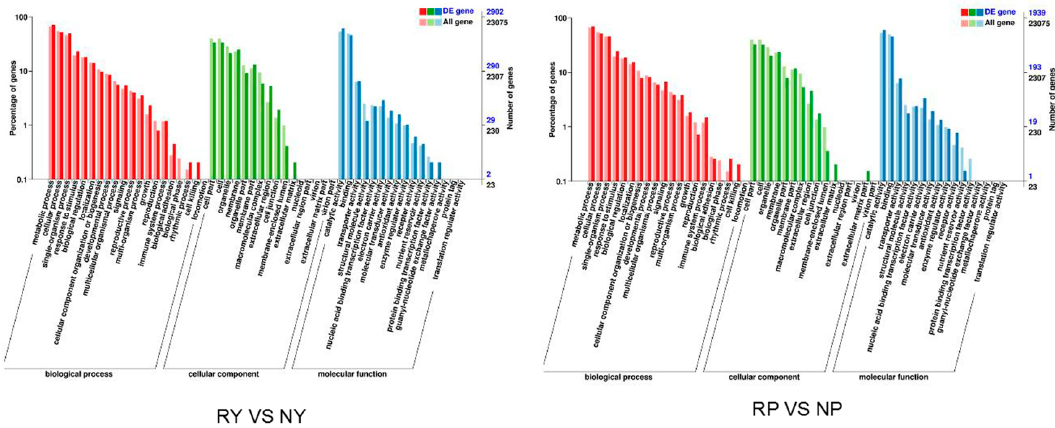
Figure 2. GO classification of unigenes in Juglans regia L. leaf and peel. Results are summarized in three main GO categories: biological process, cellular component, and molecular function.